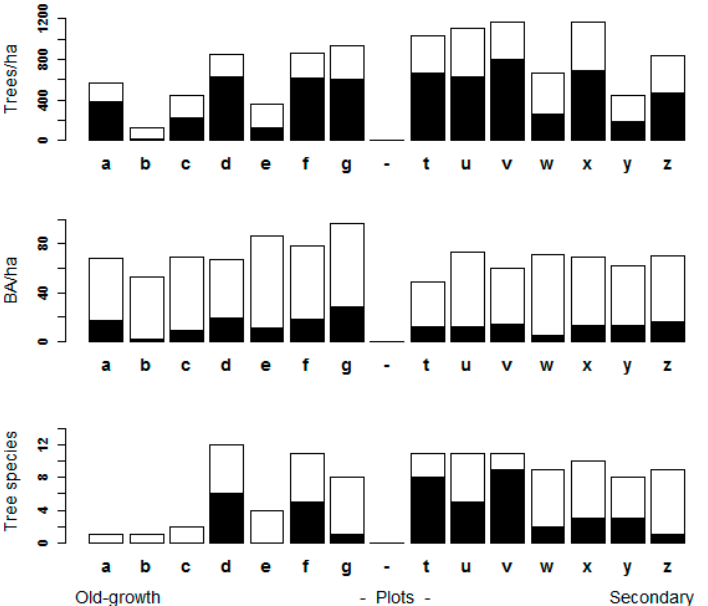
Figure 3. Plot level variables detected using an unmanned aerial vehicle (UAV). The complete bars represent the ground data measurements of the plots. The light color represents the portion of the canopy effectively detected and the black represents the portion not visualized by the UAV imagery.